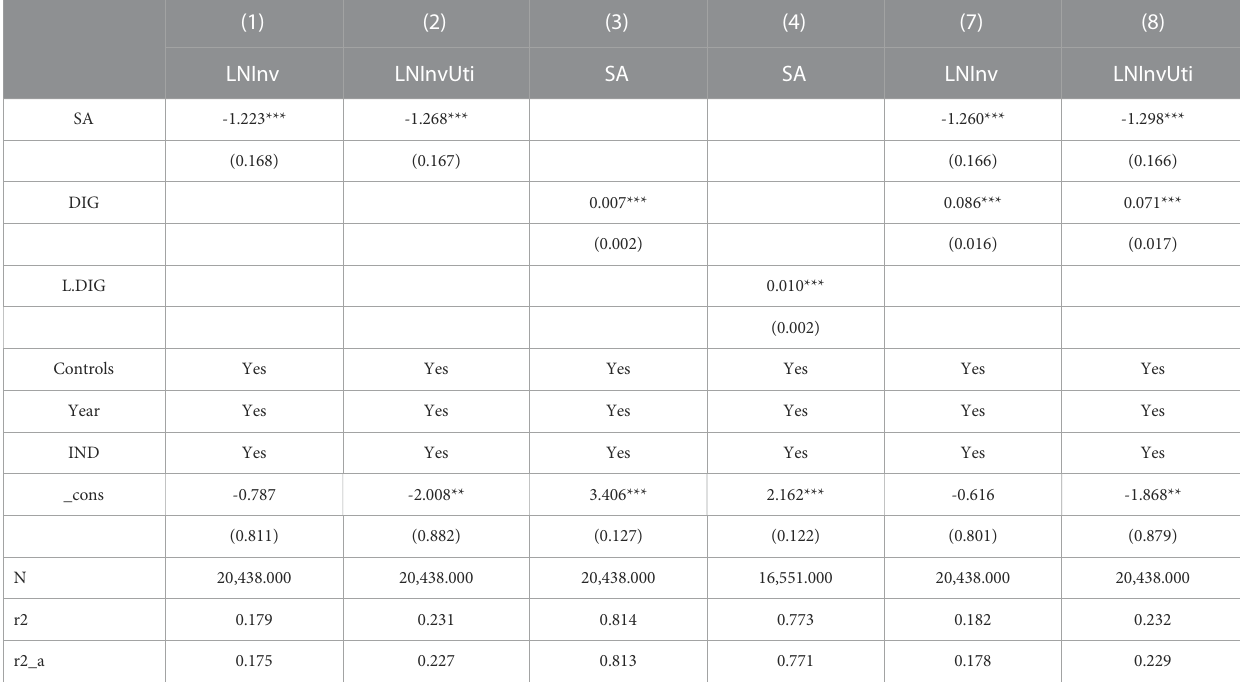
TABLE 6 Intermediate effect of fi nancing